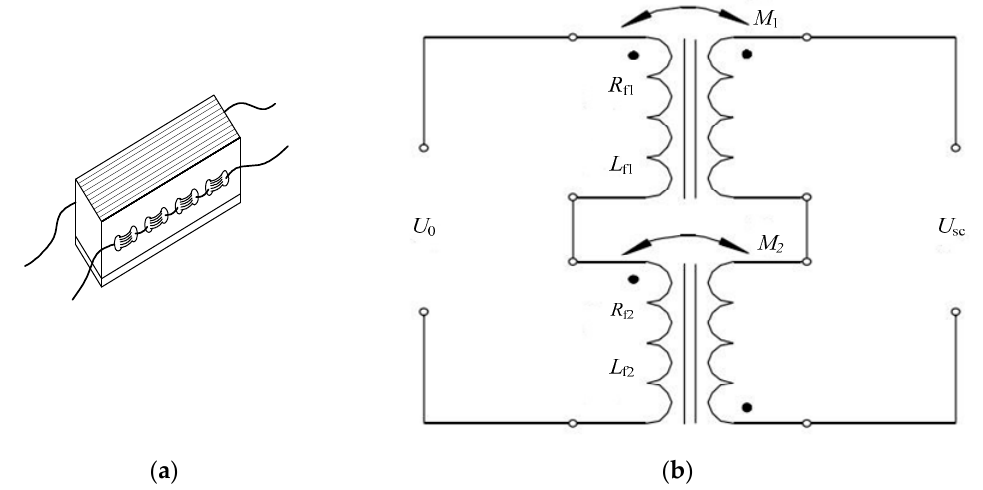
Figure 4. Pressure magnetic sensitive component: ( a ) structure; ( b ) equivalent circuit.